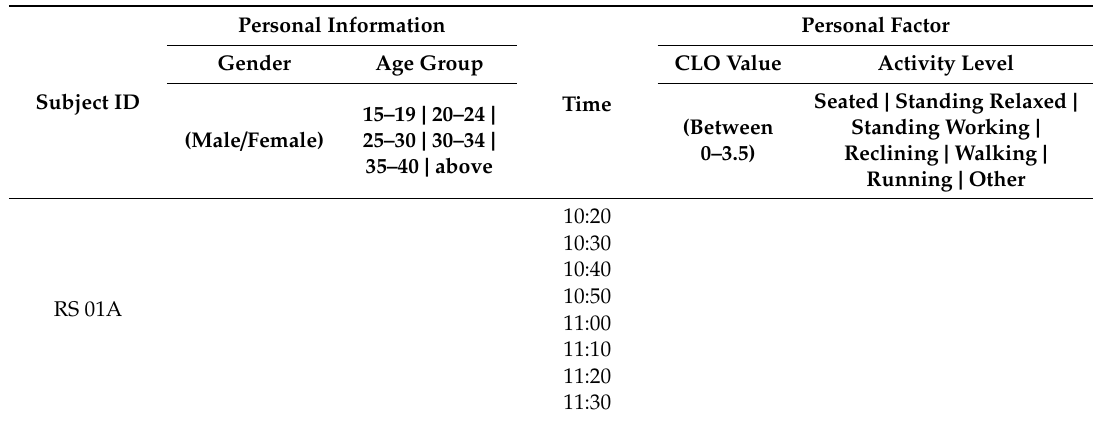
Table A2. Online Questionnaire during the educational workshops (Part 1).